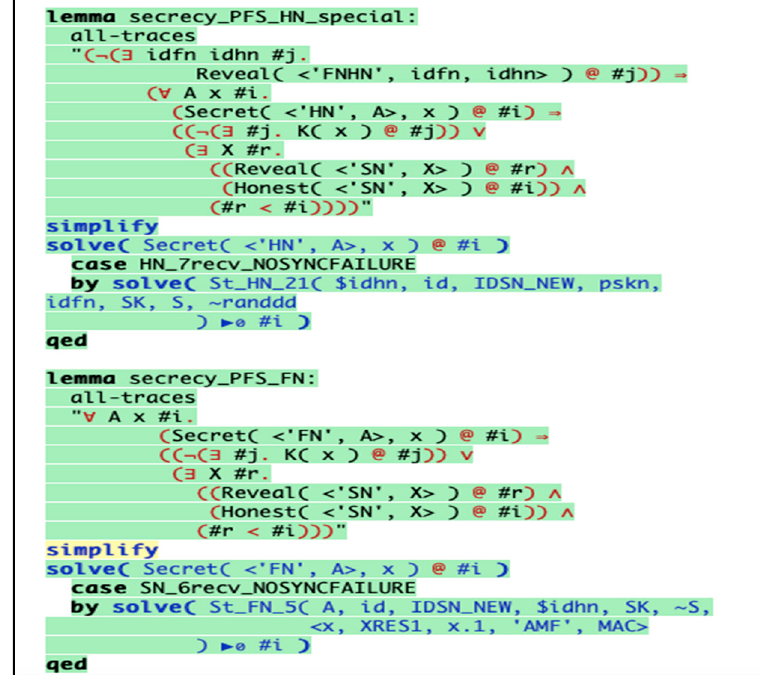
Figure 13. Replay attack resistance in HN .